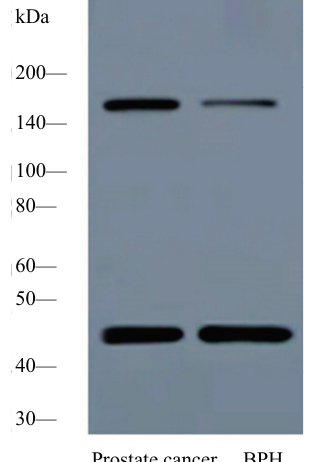
Figure 1. Representative western blot analysis of protein tyrosine kinase 7 (PTK7) expression in prostate tissues. The expression of PTK7 protein was significantly increased in prostate cancer tissues compared with benign prostatic hyperplasia tissues. Protein samples obtained from benign prostatic hyperplasia tissues and prostate cancer tissues were analysed using SDS-PAGE followed by immunoblotting with antibody against PTK7. The levels of β -actin were used as an internal